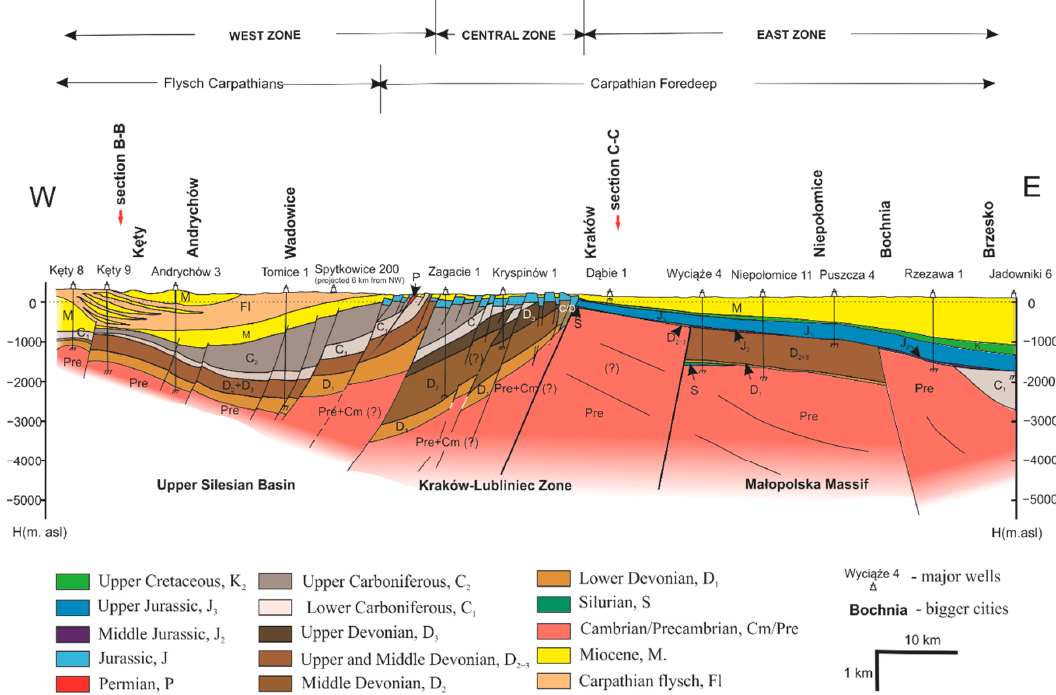
Figure 2. Schematic A–A geological cross-section through the area of analysis (based on PGNiG SA and PIG borehole data, CBDG PIG-PIB portal and according to [10, 11,13]—location in Figure 1).